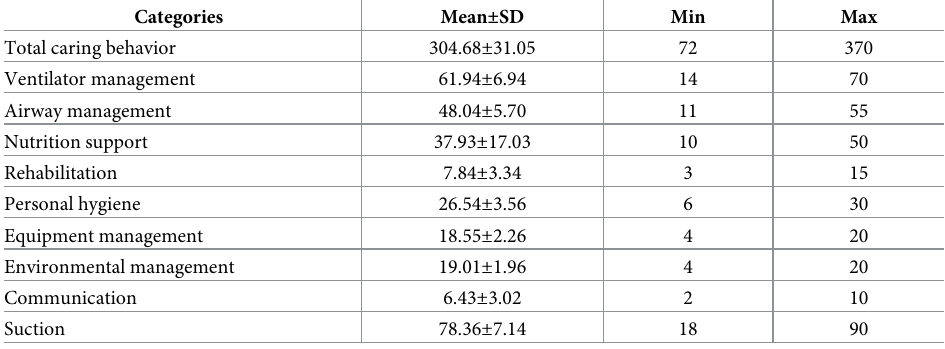
Table 3. Caring behavior scores of family